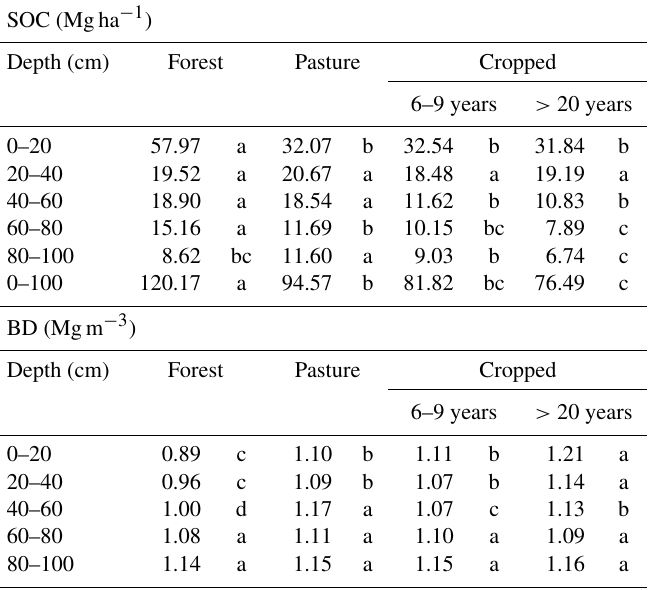
Figure 2. Variation of coarse particulate carbon (2000–212µm, CPC), fine particulate carbon (212–53µm, FPC) and resistant organic carbon ( < 53µm, RC) associated with land use. (a) Depth 0–5cm. (b) Depth 5–20cm. Different letters indicate significant differences between land use categories within each depth interval ( P < 0 . 05). Table 3. Soil organic carbon (SOC) and bulk density (BD) variation in depth associated with land use: forest, pasture, 6–9-year and > 20-year cropped soils. Different letters indicate significant differences between land use categories within each depth